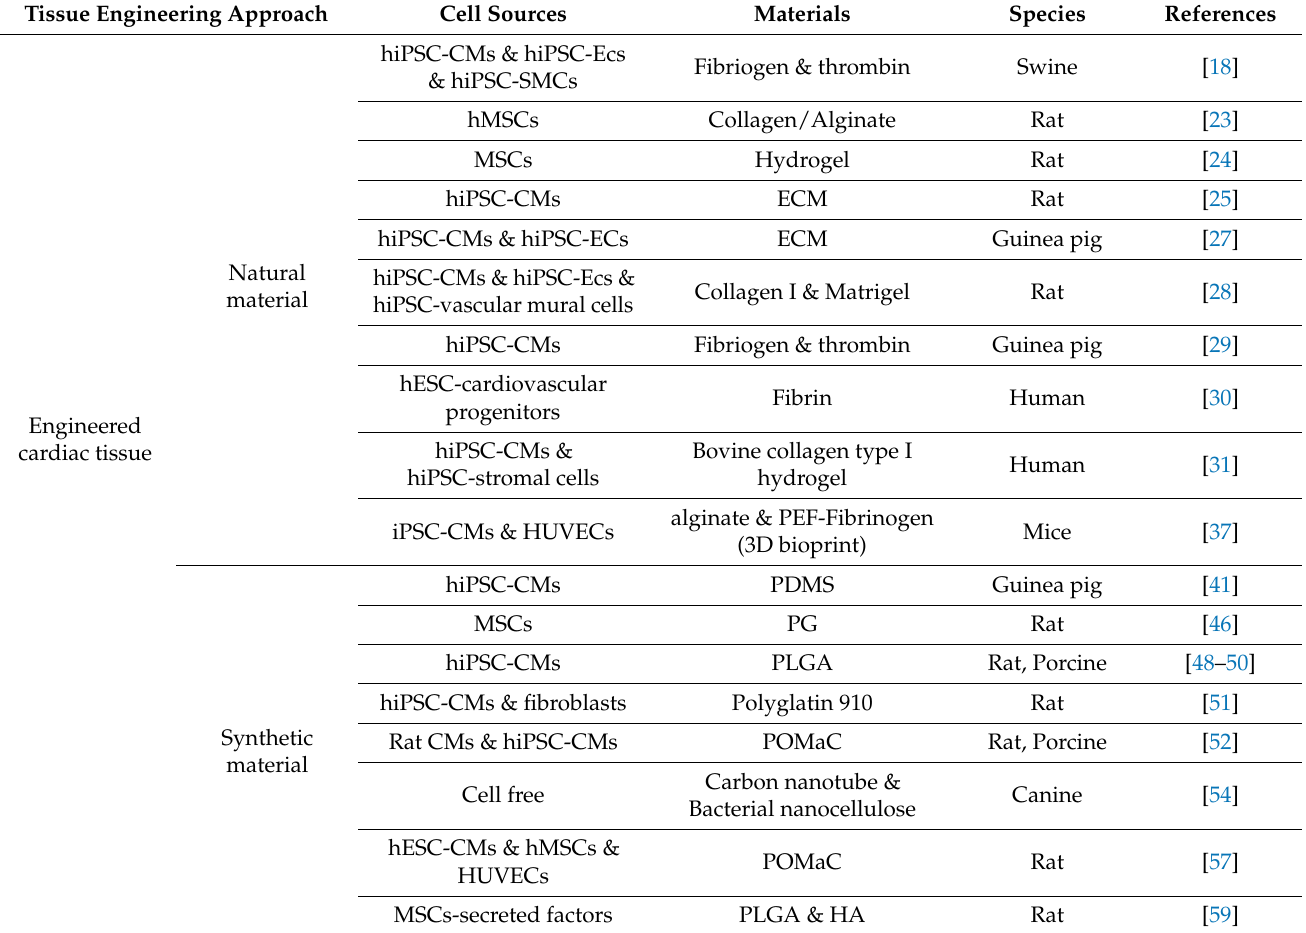
Figure 4. Cardiac sphere used for treating heart failure model. ( A , B ) CardioClusters made by mixing cardiac interstitial cells, MSCs, EPCs, and cCICs. Reproduced from Monsanto et al. [98] with permission. Copyright 2020, the Authors. ( C ) Injection device with multiple needles for optimal distribution and improved sphere retention. Reproduced from Tabei et al. [106] with permission. Copyright 2019, the authors. MSCs, mesenchymal stem cells; EPCs, endothelial progenitor cells; cCICs, c-Kit+ cardiac interstitial cells. Table 1. Characteristics of tissue-engineering approaches.